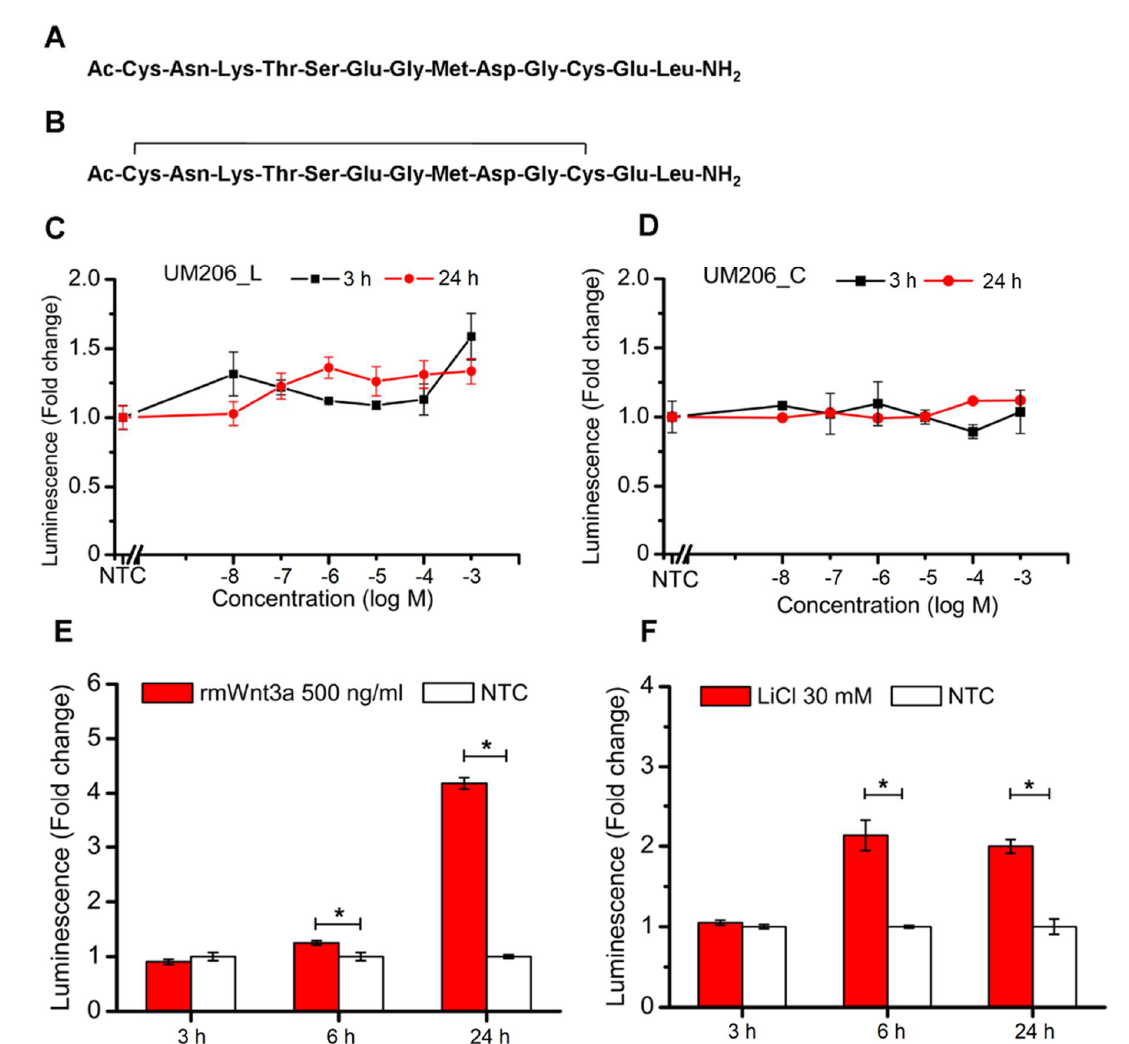
Figure 2. Effect of peptides and two agonists on the activation of canonical Wnt signaling transduction. ( A , B ) Sequence of UM206_L, UM206_C. ( C , D ) TCF/LEF signaling transduction induced by indicated peptide concentration for UM206_L ( C ), UM206_C ( D ) 3 h ( (cid:4) ) and 24 h ( • ) post-treatment in HEK293 Luc-TCF/LEF cells ( n = 3). ( E , F ) The stimulatory effect of 500 ng/mL rmWnt3a ( E ) and 30 mM LiCl ( F ) treatment on TCF/LEF transduction at the indicated time points ( n = 4). In ( C – F ), luminescence was presented as fold change with respect to non-treated control (NTC), which was set to 1. The data are expressed as mean ± SEM obtained from two independent experiments (* p <